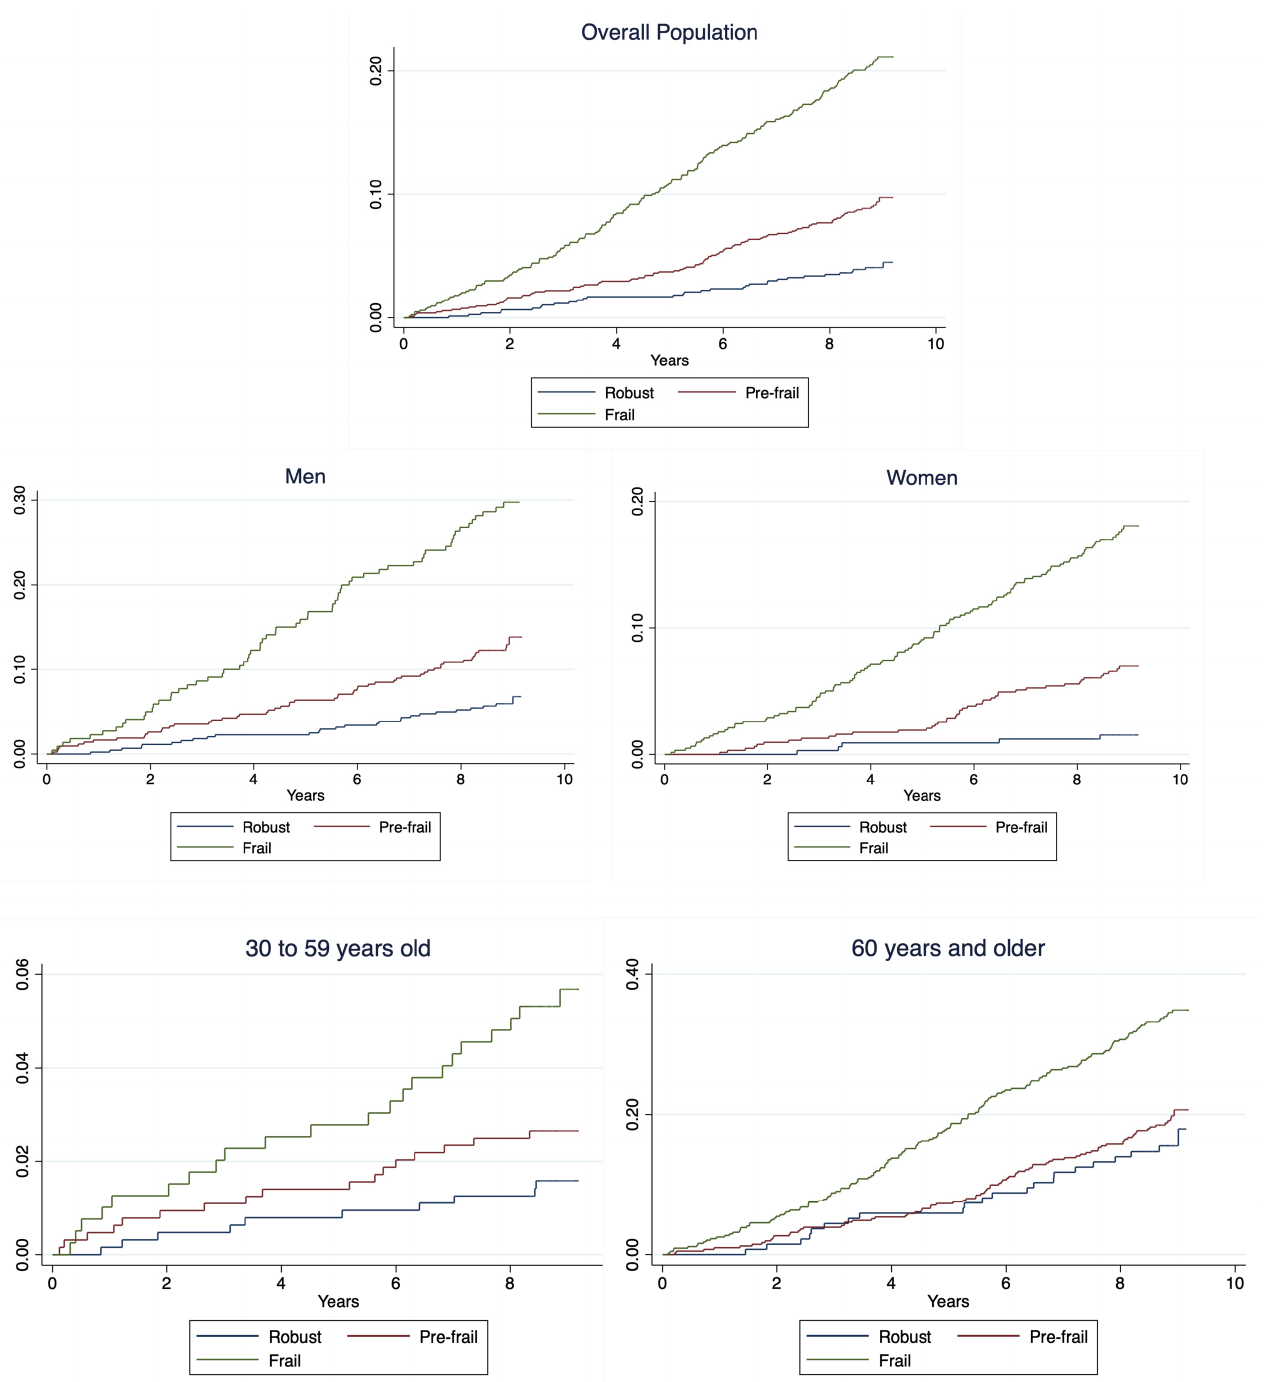
Figure 2. Kaplan–Meier failure estimates for general population and stratified by sex. Associations between the frailty status and all-cause mortality, stratified by sex and age group, are shown in Table 2. In the unadjusted model, and compared with robust participants, frail individuals had a 5.51-times higher risk of death (HR model 1: 5.51 [95%CI 3.78 to 8.04]). The association was attenuated after adjusting for the covariates included in cant (HR model 3: 2.35 [95%CI 1.57 to 3.51]). The mortality risk in pre-frail individuals was 2.34-times higher than in robust participants for the unadjusted model. However, this as- sociation was fully attenuated after further adjustment (HR:1.28 [95%CI 0.85 to 1.92]). In sex-stratified models, the risk of dying was higher in frail women than frail men (HR women